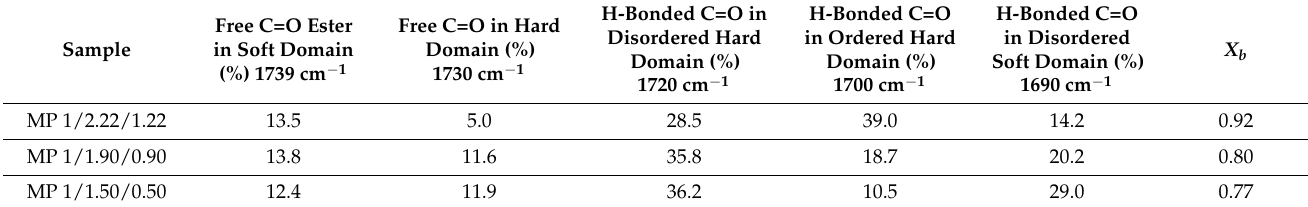
Table 3. Percentages of the various C=O species present in the shape memory thermoplastic polyu- rethanes, as determined by deconvolution of the FTIR absorbance bands in the range of 1750–1680 cm −1.